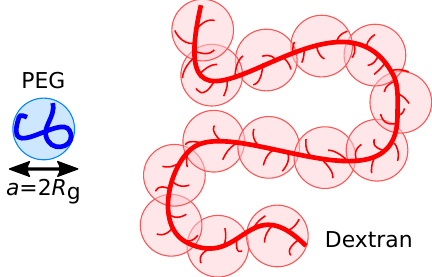
Figure 1. Schematic representation of the model, illustrating the coarse-graining of PEG and Dextran